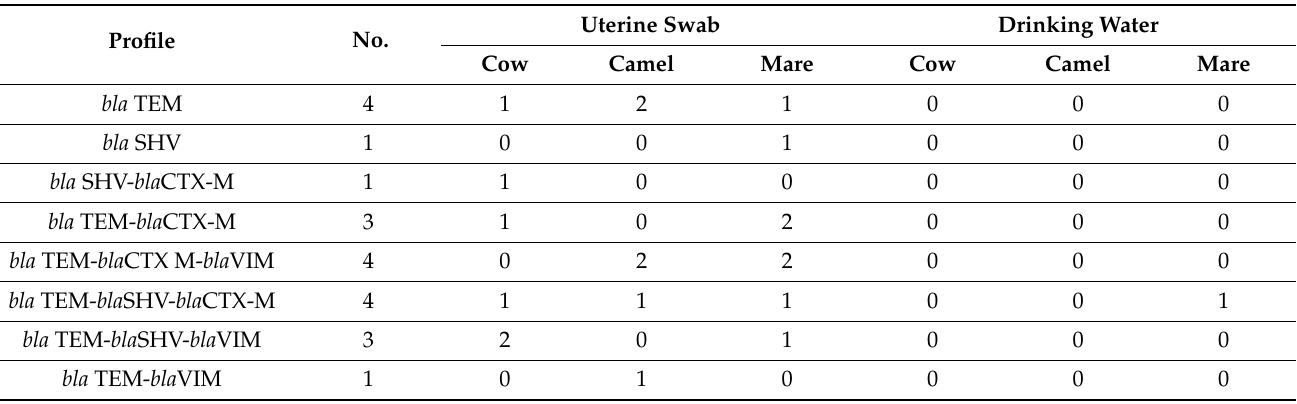
Table 5. Beta-lactamase gene types in phenotypic ESBL and MBL P. aeruginosa ( n = 21) recovered from uterine swabs and drinking